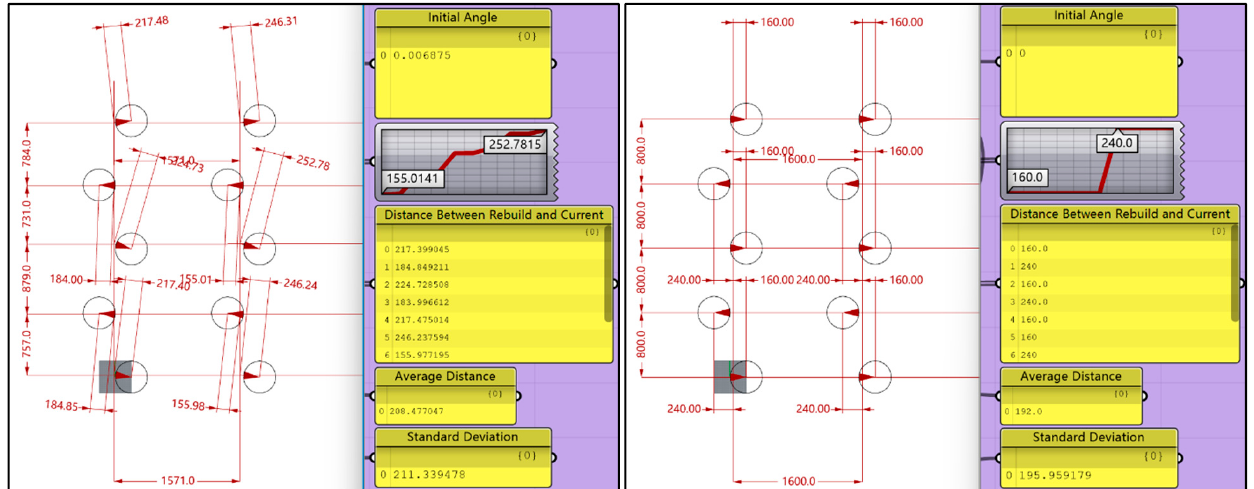
Figure 17. Verification of 10 asymmetric columns (the disordered axes on the left, the result axes on the right).